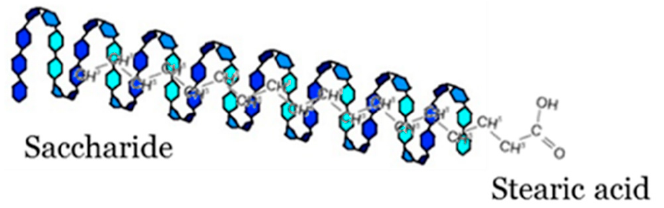
Figure 1. Proposed structure of saccharide-stearic acid.